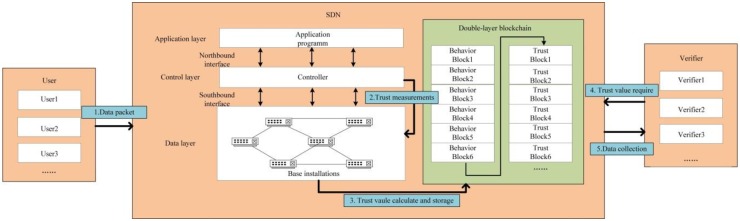
Overview of TrustBlock.